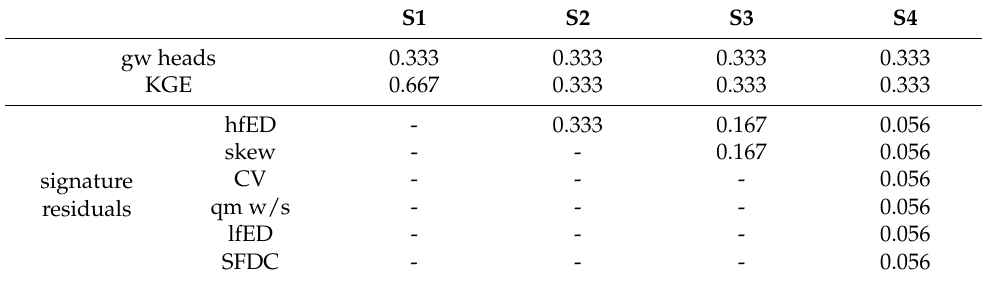
Table 3. The four calibration scenarios with their relative objective function